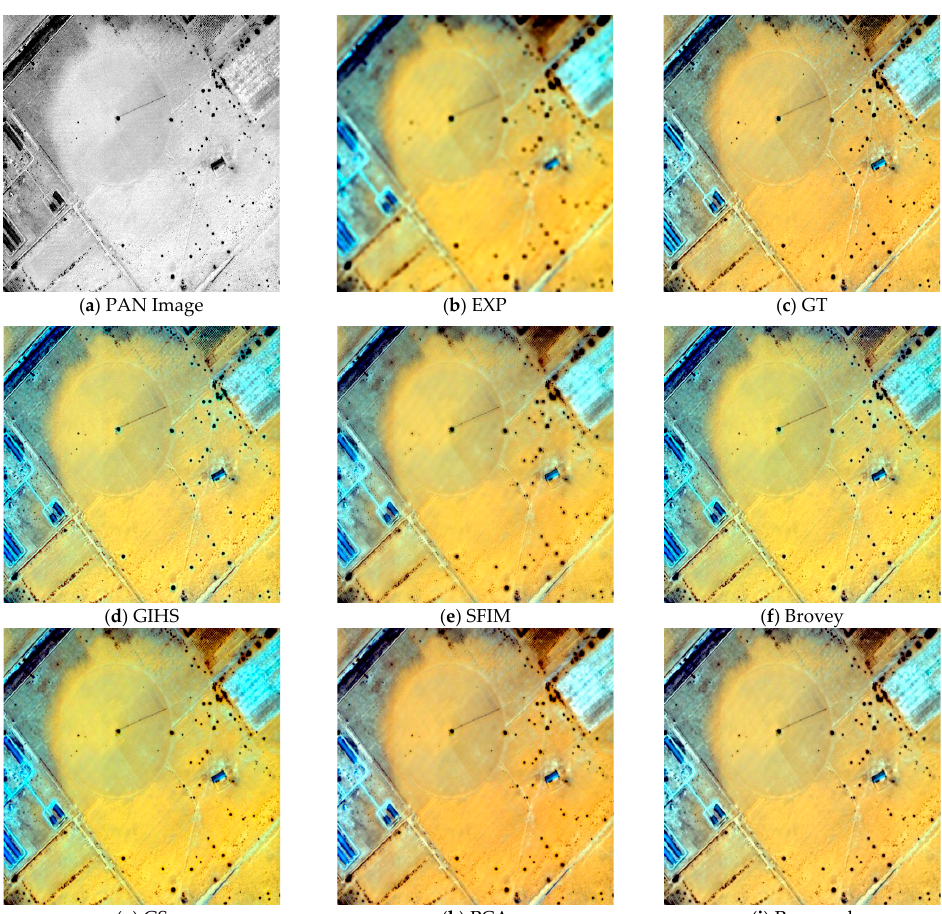
Figure 7. Fusion results for the GFDM images using different methods.